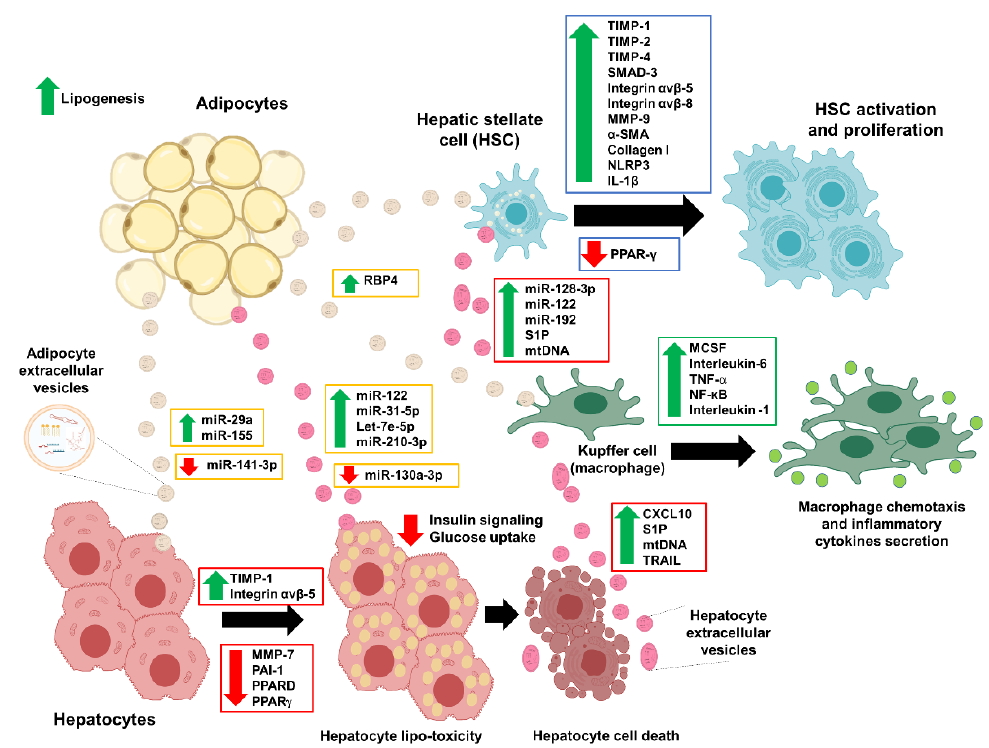
Figure 4. Illustration of the extracellular vesicles’ involvement in NAFLD development. Adipocyte- derived extracellular vesicles mediate the endocrine effects in hepatocytes, hepatic stellate cells, and macrophages (Kuffer cells) in the early phase of the NAFLD development. The disease progression becomes worse when the hepatocytes release their extracellular vesicles that promote the formation of fibrosis. The green arrow represents upregulation, and the red arrow represents downregulation. Abbreviation: α -smooth muscle actin ( α -SMA), C-X-C-motif chemokine 10 (CXCL10), interleukin-1 β (IL-1 β ), macrophage colony-stimulating factor (MCSF), matrix metalloproteinase-7 (MMP-7), matrix metalloproteinase-9 (MMP-9), mitochondrial DNA (mtDNA), non-alcoholic